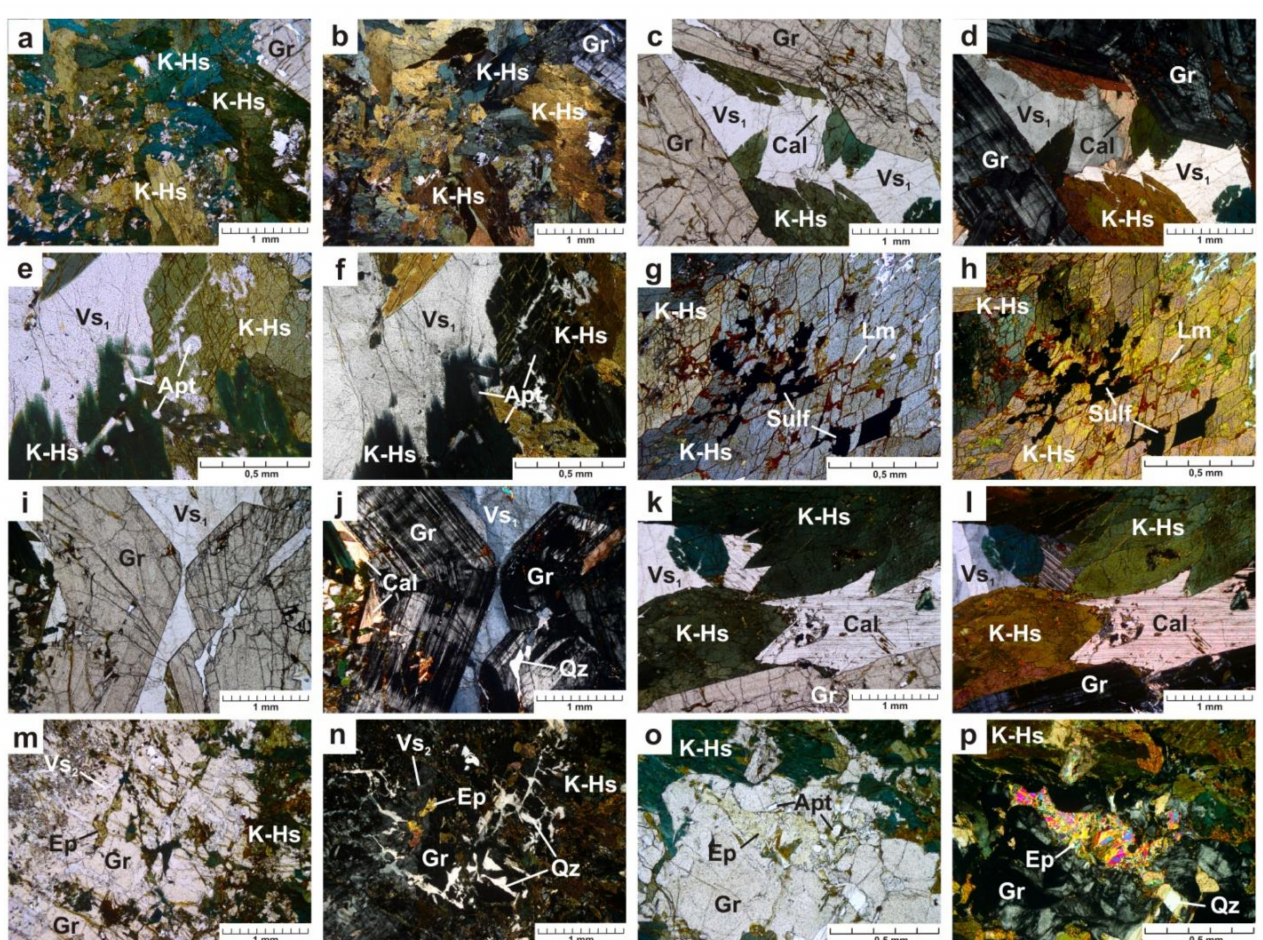
Figure 3. Photomicrographs of the mineral assemblages and their textural properties in a thin section in transmitted light, ( a , c , e , g , i , k , m , o )—plane polarised light and ( b , d , f , h , j , l , n , p )—cross polarised light image. Cal—calcite, Ep—epidote, Gr—garnet, K-Hs—potassic-hastingsite, Lm—minerals of the limonite group, Qz—quartz, Sulf—sulfides, Vs 1 and Vs 2 —vesuvianite of the first and second generation, respectively. Mineral abbreviations are used according to